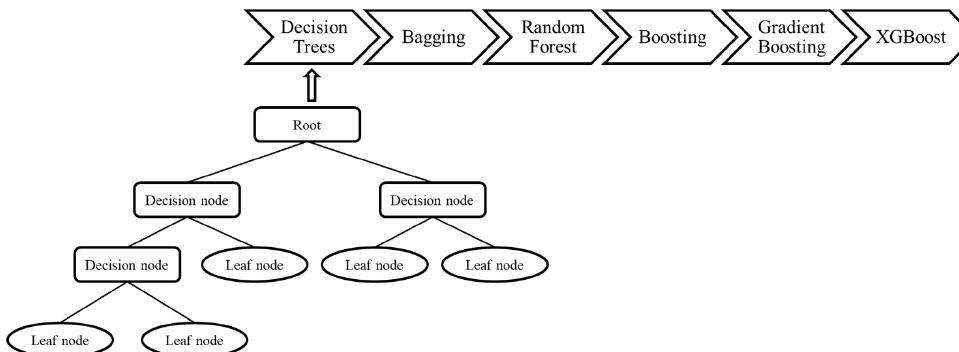
Figure 3. Schematic of evolution from decision tree to